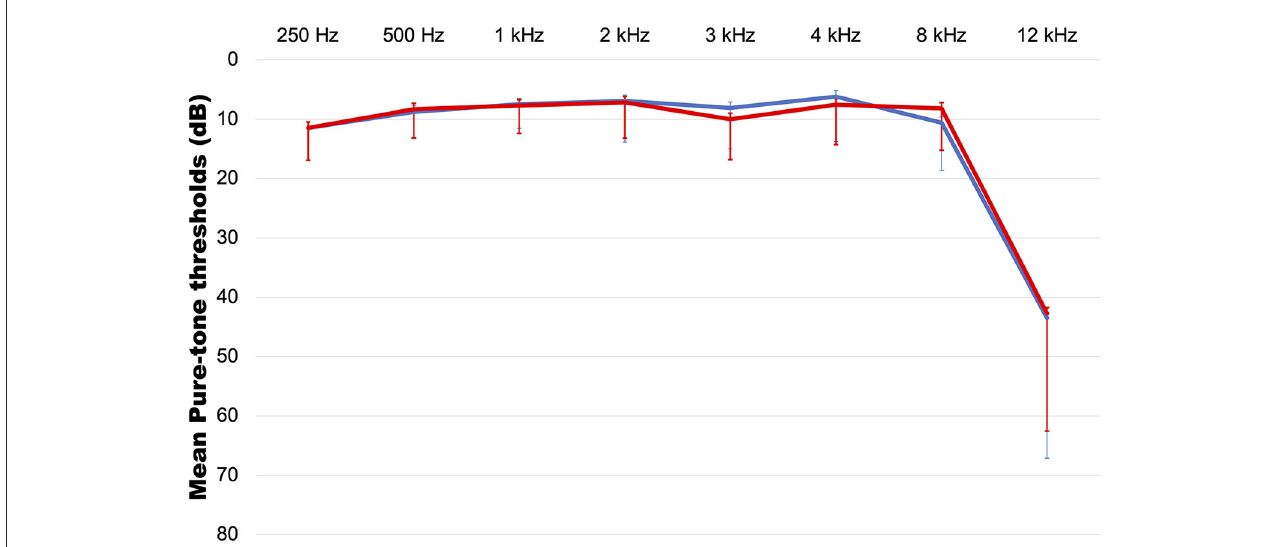
FIGURE1 The average audiogram. red line: right side, blue line: left side. Error bar indicates standard deviation.